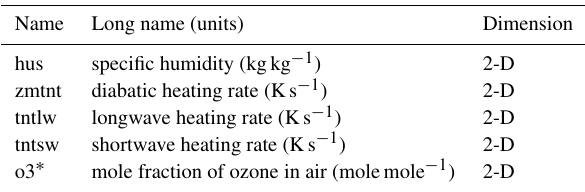
Table 3. Thermodynamics. Monthly mean and daily mean zonal mean fields (YPT). P is the standard 30-level set of diagnostic pres- sure levels described in Sect. 4.1 (also Table 1